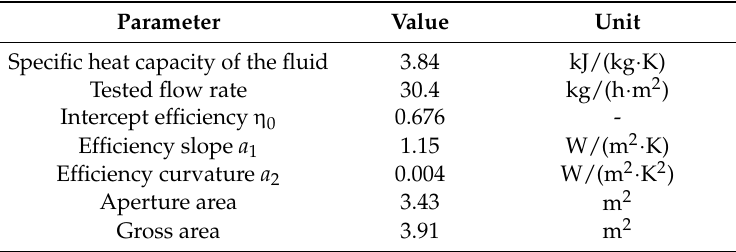
Table 3. Evacuated tube collectors